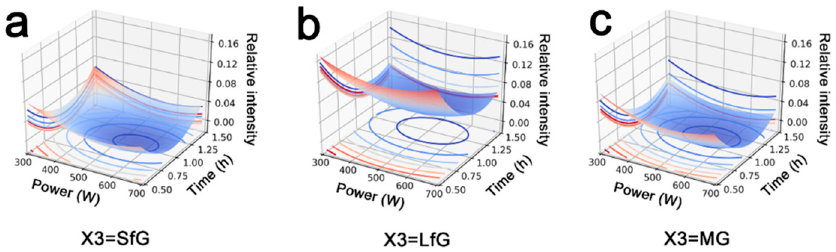
Figure 1. Effect of the exfoliation of graphene (Y) to ultrasonication power (X1) and time (X2) when the graphite is ( a ) small flaky graphite (X3 = SfG), ( b ) large flaky graphite (X3 = LfG), and ( c ) microcrystalline graphite (X3 = MG).